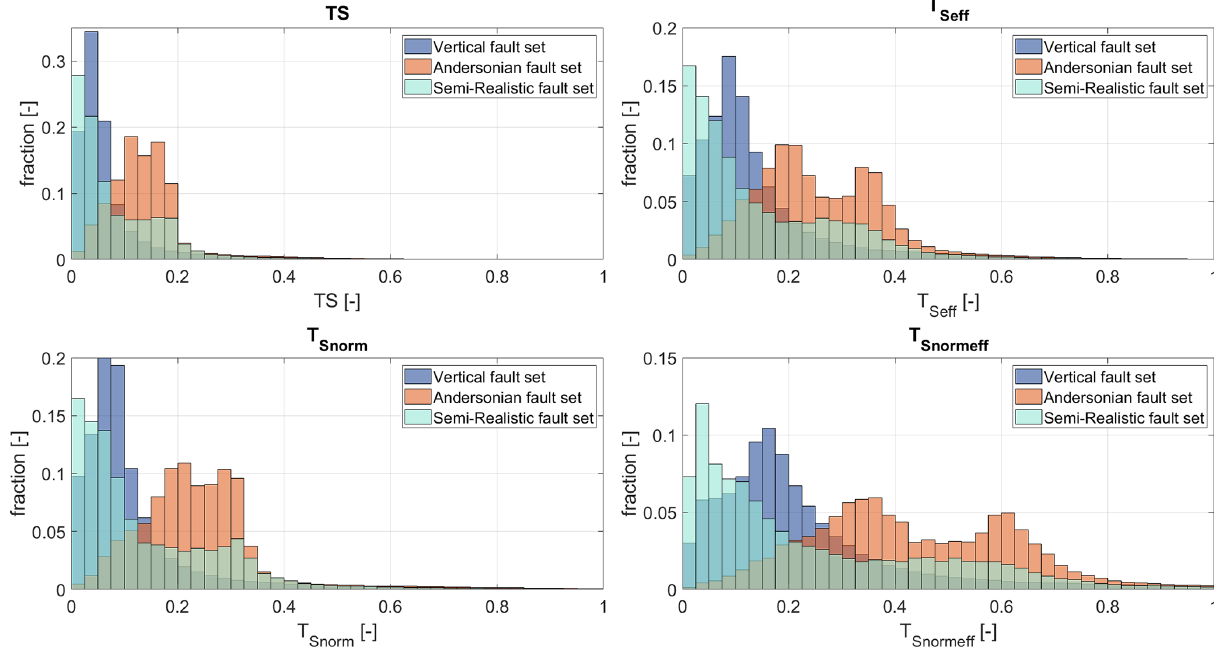
Figure 10. Comparison of the slip tendency histograms of the Vertical (blue), Andersonian (orange) and Semi-realistic (mint) fault set for the four slip tendency types. Slip tendency values greater than 1 are not shown. The slip tendency values have been calculated on the nodes of the fault mesh; mesh resolution is 800m for all three fault sets. Bin size is 0.025.